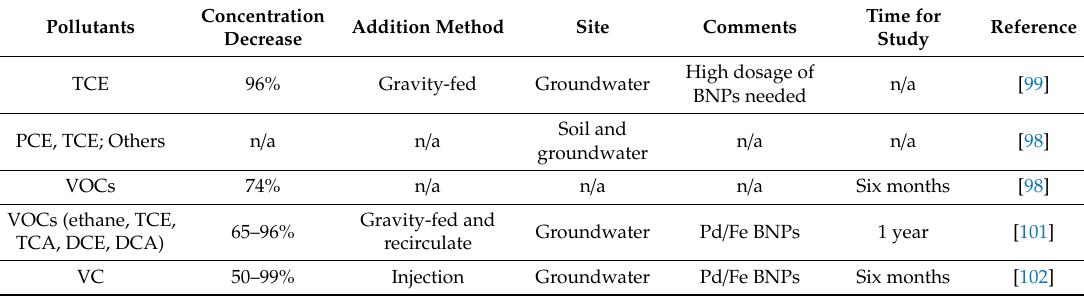
Table 3. Summary of pilot and field scale studies of